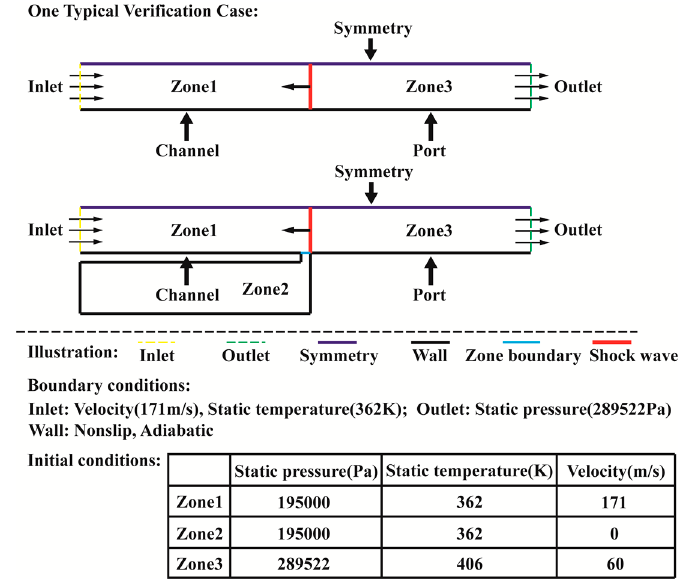
Figure 14. Initial and boundary conditions for one typical verification case.